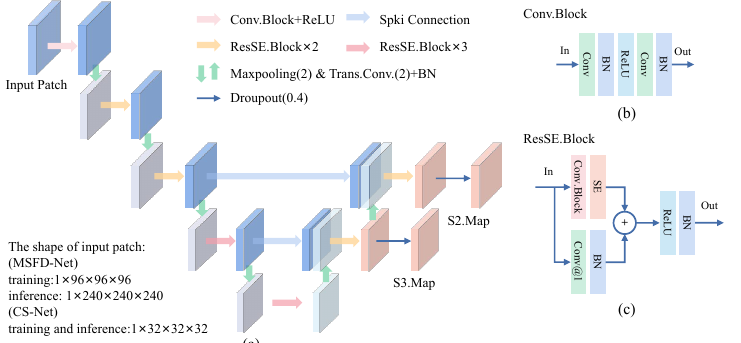
Figure 5. The architecture of the proposed multi-scale feature extractor (MSFE). ( a ) The MSFE extracts the multi-scale features S2.Map and S3.Map from the input patch. ( b ) Structure of the basic module Conv.Block. ( c ) Structure of the basic module ResSE.Block. Conv@1 means a 3D convolution with a kernel size of 1 × 1 × 1. In our modules, note that the kernel size of convolutions is 3 × 3 × 3, and the stride and padding are 1 unless otherwise specified.